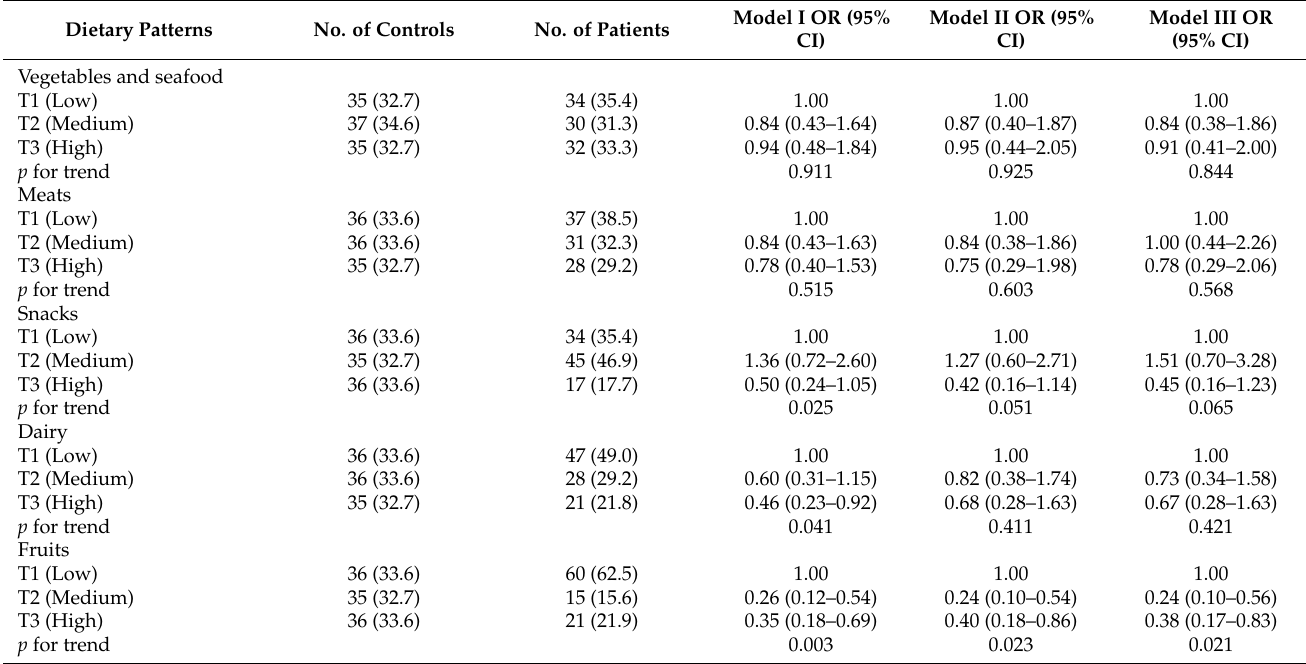
Table 3. Association between dietary pattern networks derived from GGMs and the GC risk in females. Dietary